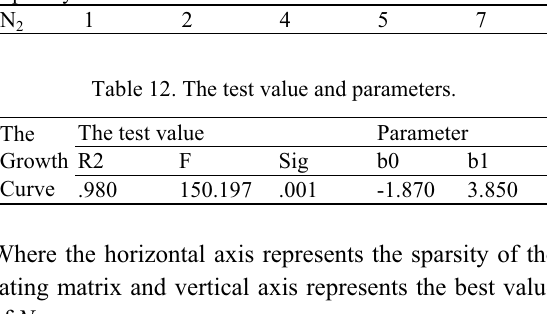
Fig. 4. Integrated fitting curve for experiment